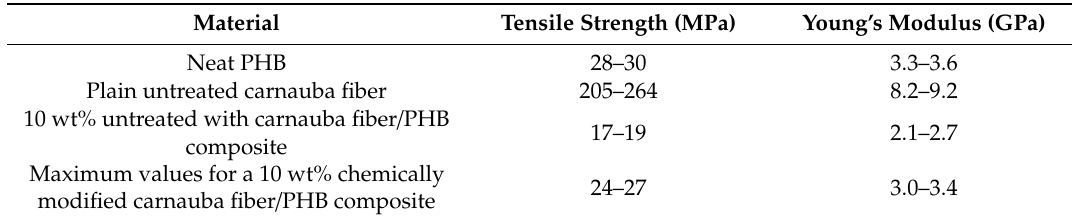
Table 1. Mechanical properties of plain untreated carnauba fiber neat polyhydroxybutyrate (PHB) and 10 wt% carnauba fiber PHB composites, reproduced from [26].